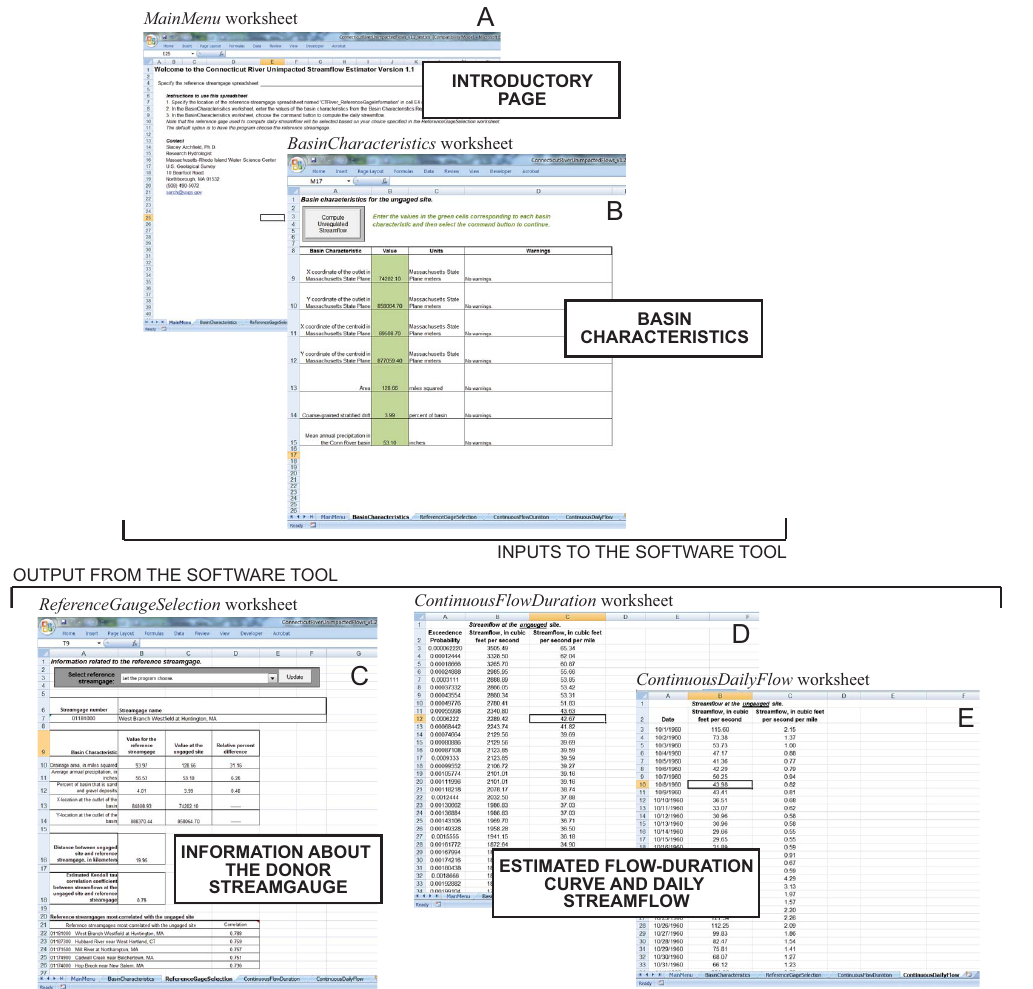
Fig. 4. Screen captures showing the spreadsheet portion of the software tool used to estimate daily, unregulated time series. After reading the introductory page (A) , the user inputs the catchment characteristics (or basin characteristics, as named in the tool) into the BasinCharac- teristics worksheet (B) . The spreadsheet program then selects the donor streamgauge (C) and generates the flow-duration curve (D) and the daily streamflow time series (E)